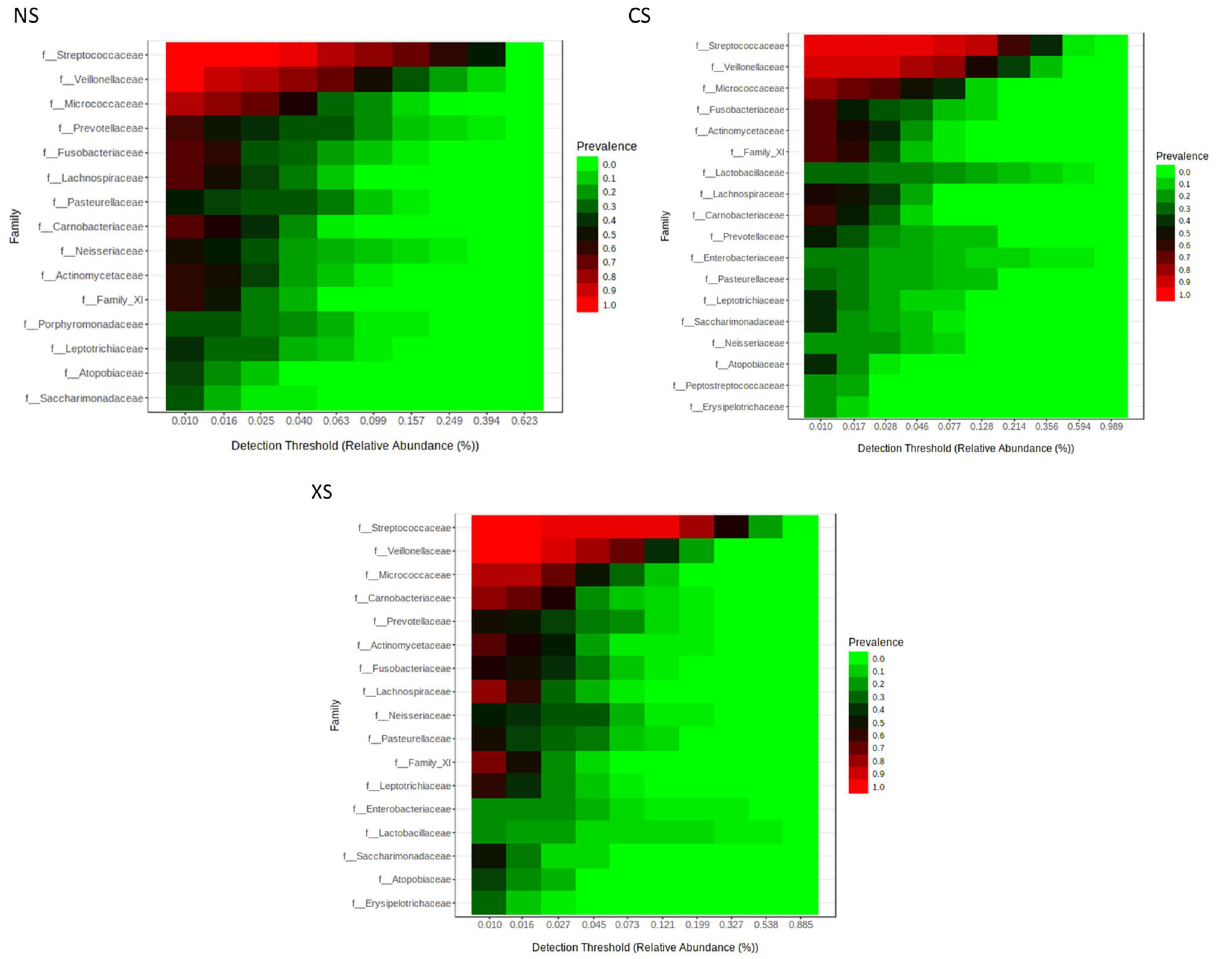
Figure 2. The common duodenal luminal microbiome at the family level in never-smokers ( A ), current smokers ( B ) and ex-smokers ( C